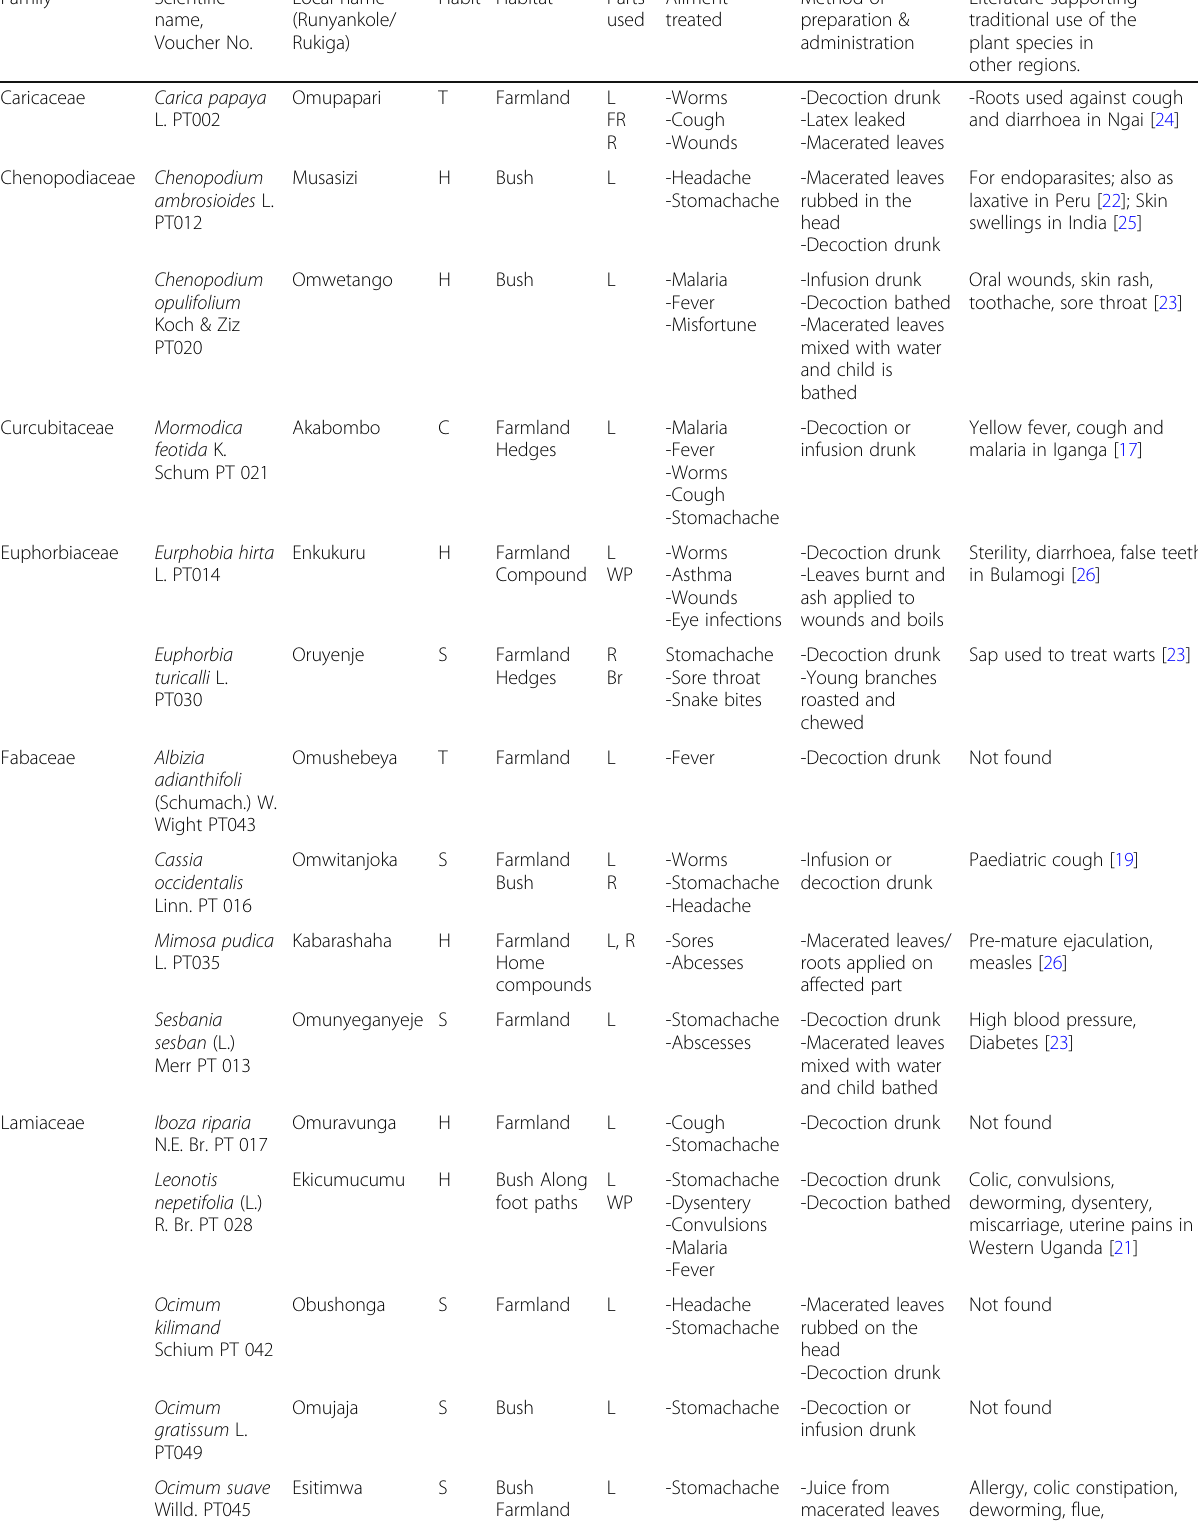
Table 1 Medicinal plant species, their habit, habitat, parts used, ailments treated, mode of preparation and administration